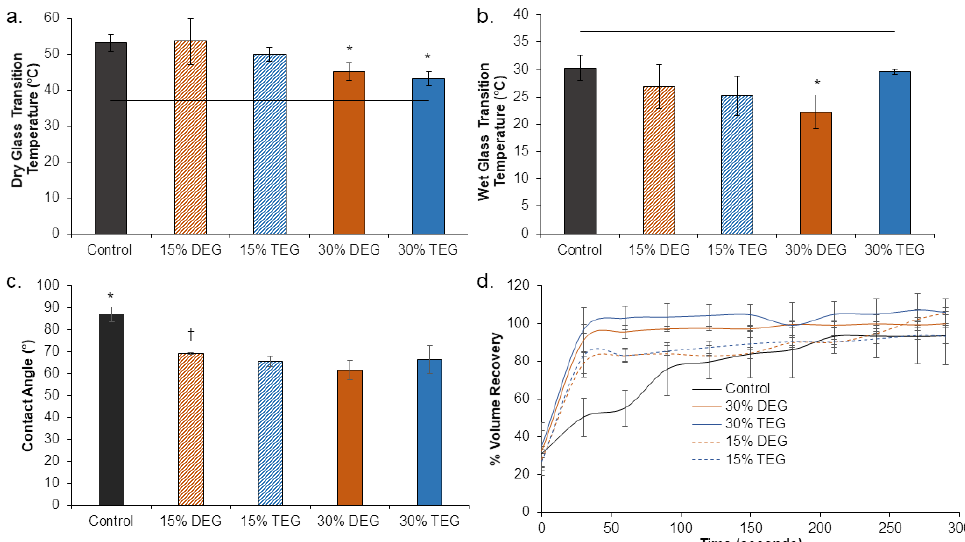
Figure 2. Thermal, shape memory, and hydrophilicity properties of SMP foams. ( a ) Dry glass transition temperature (n = 3, * p < 0.05 relative to control), ( b ) wet glass transition temperature (n = 3, * p < 0.05 relative to control), horizontal line is provided as a reference for body temperature (37 °C) in ( a , b ). ( c ) contact angle (n = 5, * p < 0.05 relative to all other samples, † p < 0.05 relative to 15% TEG and 30% DEG samples), and ( d ) volume recovery of samples (n = 3) in deionized water at 37 °C. Mean ± standard deviation displayed in all panels.